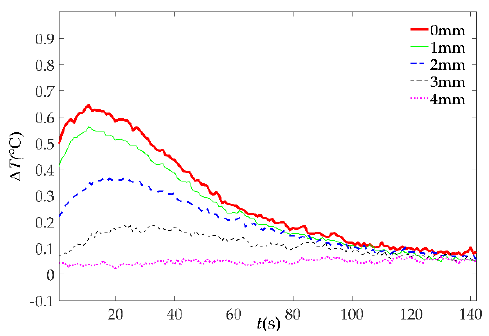
Figure 18. The surface temperature difference curves of the MFI thermal excitation.